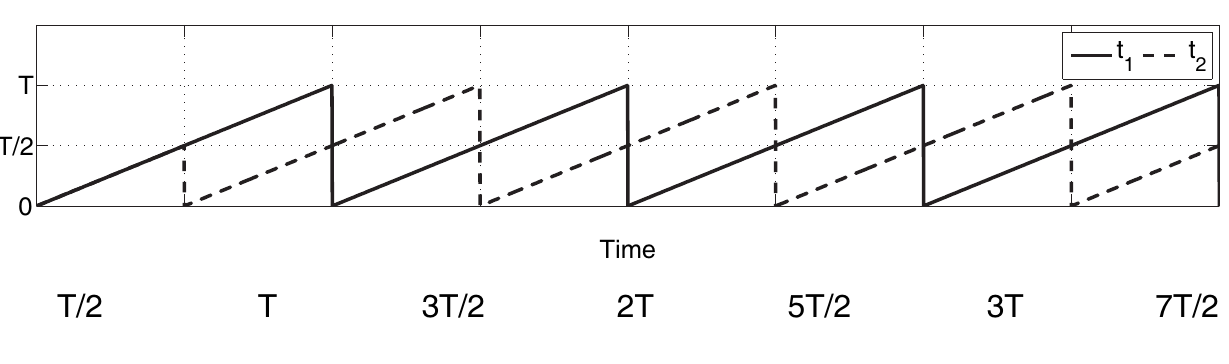
Figure 1. Time setting for each